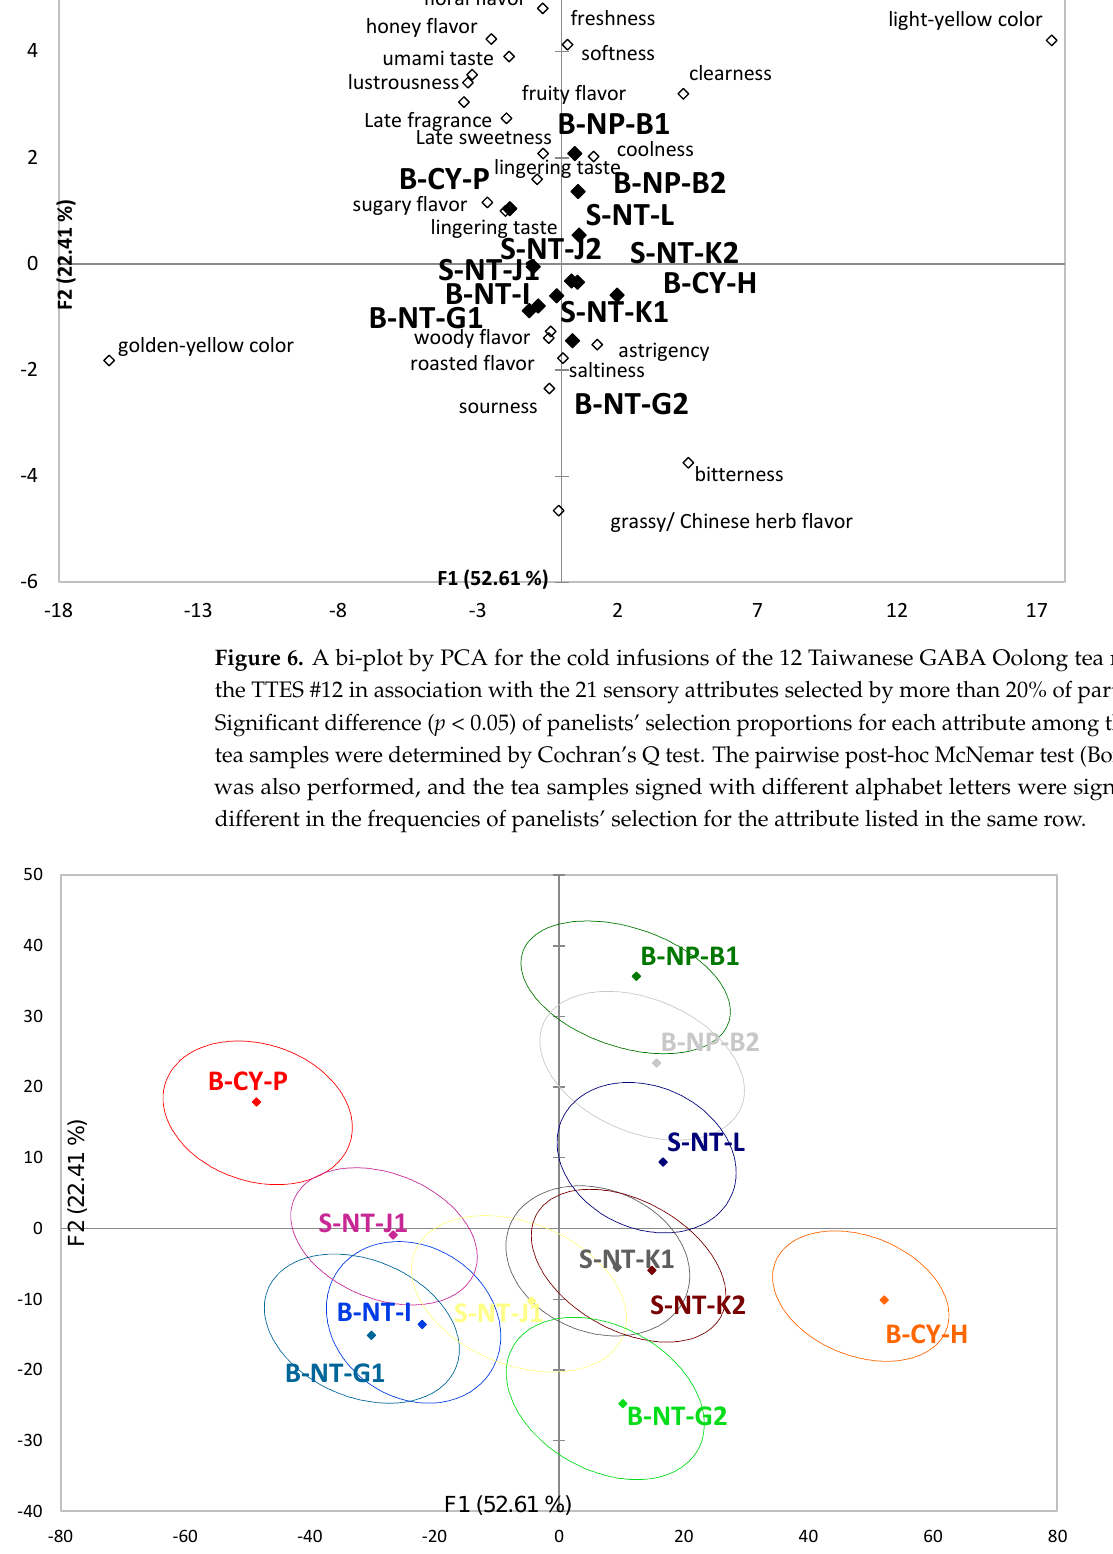
Figure 7. The partial least squares regression (PLSR) correlation loading plot of sensory, association, postprandial perception attributes, and overall liking of 12 Taiwanese GABA Oolong teas.